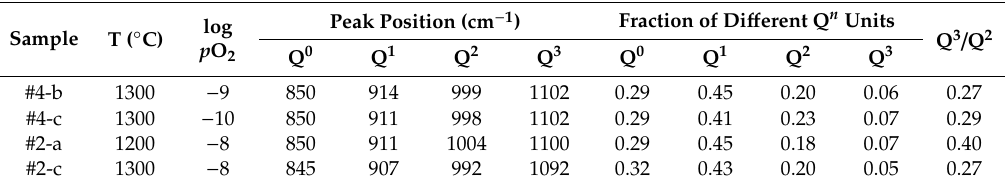
Table 5. FTIR peak shift and area fraction obtained from FTIR spectra of FCSM-Cu 2 O-PdO slags equilibrated under di ff erent temperature and p O 2 conditions